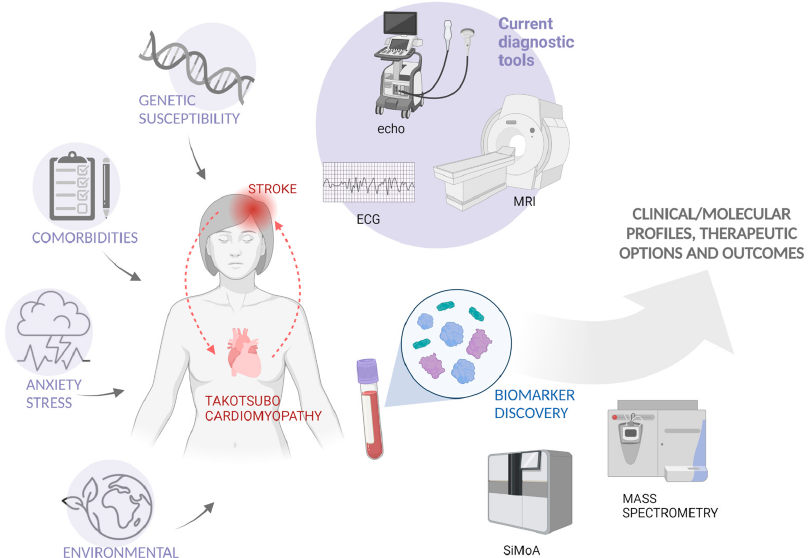
Figure 3. A schematic representation of the association between Takotsubo cardiomyopathy (TC) and acute ischemic stroke, as a result of putative genetic predisposition, environmental triggers, and concomitant comorbidities. The biomarker discovery by innovative technologies could be useful to investigate clinical profile, therapeutic options, and outcomes of TC patients. SiMoA (Single Molecule Array). Created with